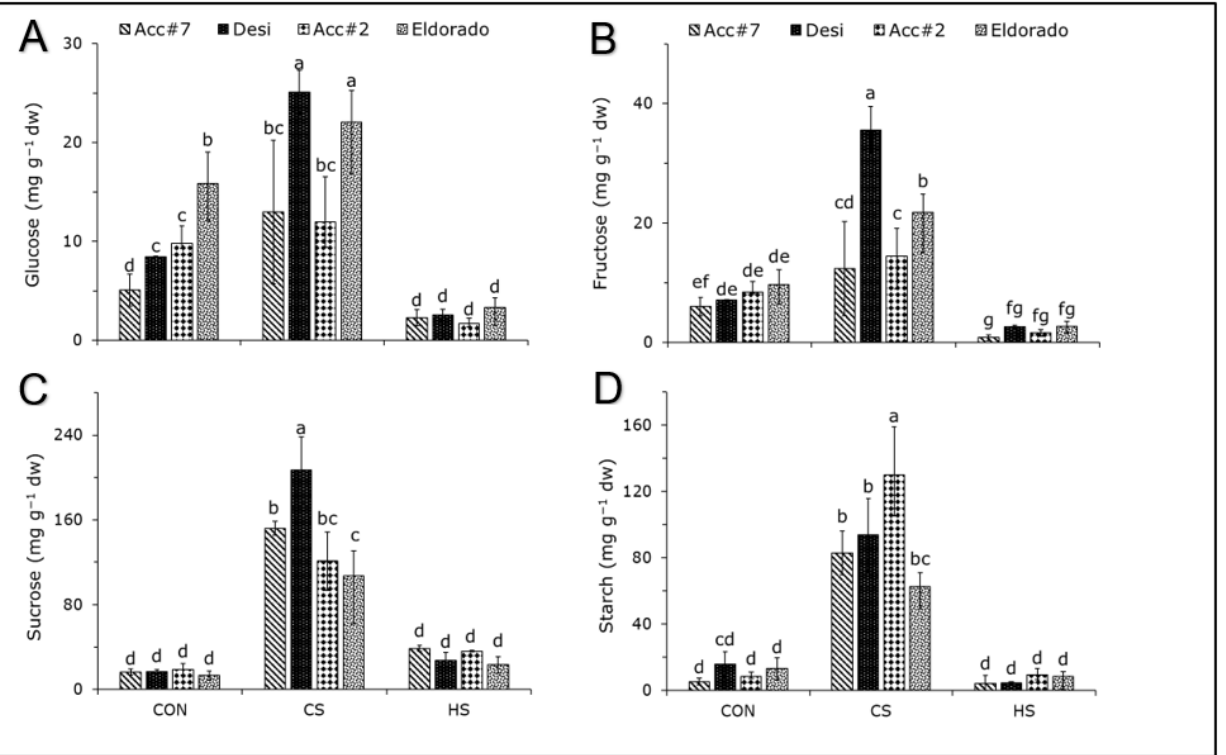
Figure 5. ( A ) Glucose, ( B ) fructose, ( C ) sucrose and ( D ) starch in the second fully expanded top leaves of four chickpea genotypes under the treatments for 3 days. “CON”, 25/20 ◦ C day/night; “CS”, 8/4 ◦ C day/night; “HS”, 38/33 ◦ C day/night. The data represent average values ± SD ( n = 3). Different small letters above the bars indicate significant differences ( p <